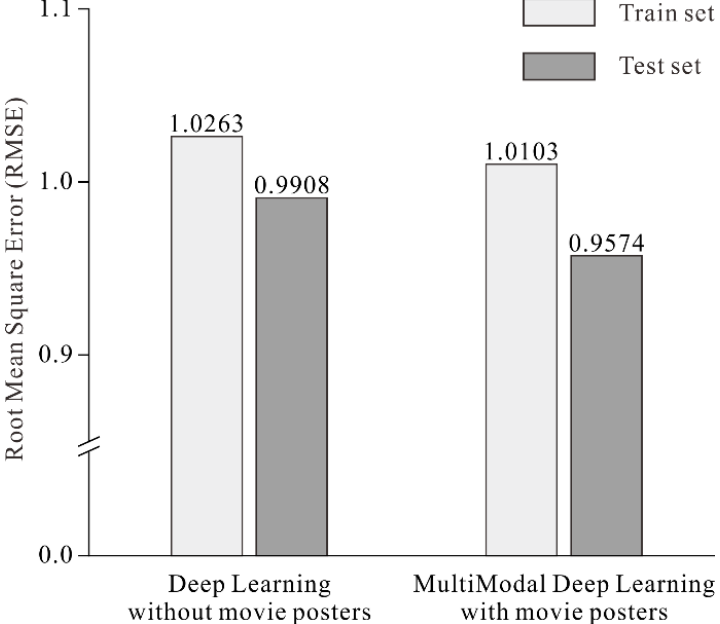
Figure 7. The RMSE scores for recommendation systems using deep-learning algorithm with or without movie posters based on the MovieLens 100 K dataset.